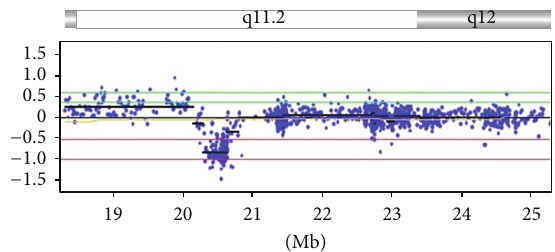
Figure 1: Chromosomal microarray analysis of Case 1 using the Combimatrix DNAarray Oligo 180 K (Combimatrix Diagnostics, Irvine, CA) showing the location of the deletion on chromosome 15 involving BP1-BP2 (20, 290, 386–20, 633, 303 bp from p terminus using content source from UCSC hg18 human genome (NCBI build 36, March 2006)). Y axis shows the chromosome copy number (0 = normal or nondeletion; − 1.0 = deletion from a single chromosome). Genes in the deleted region are CYFIP1, NIPA1, NIPA2 , and TUBGCP5